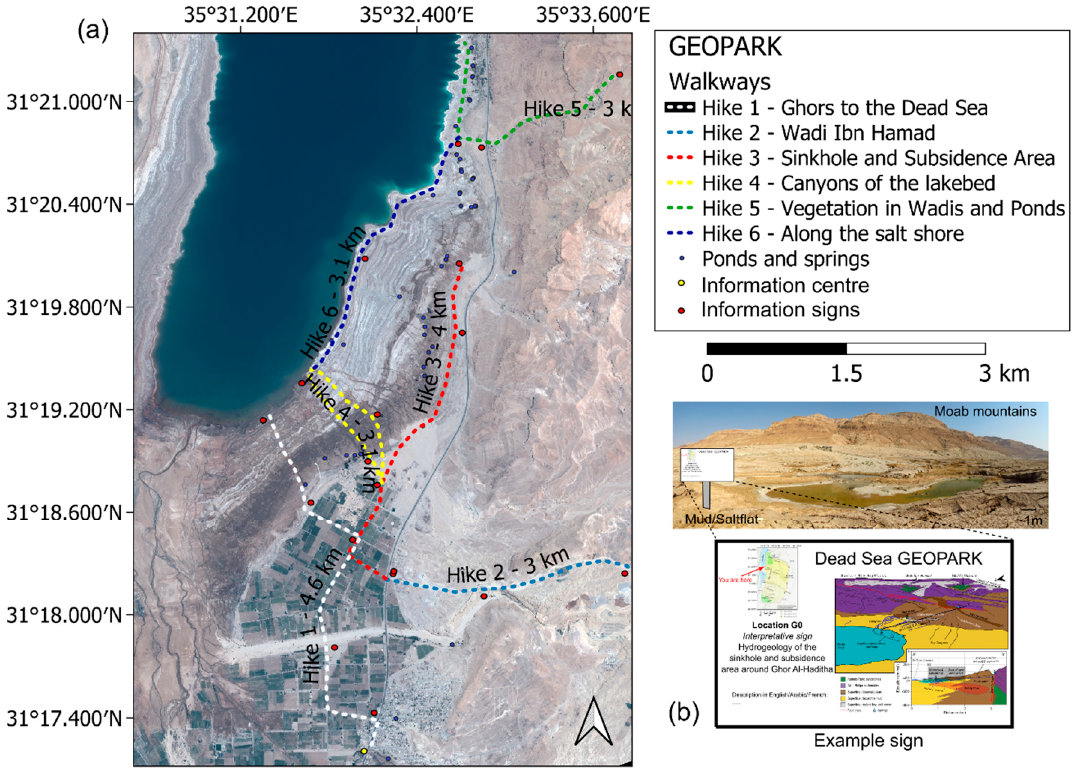
Figure 14. Hiking trail planning for the highlight area of the UGGp. ( a ) Suggested walkways in the sinkhole and subsidence zone around Ghor Al-Haditha. ( b ) is an example of a geological interpretation map for the geopark area, which can be used, e.g., in the geological museum, along the walkways for education purposes. Geological map modified after [26]. Naturally, all signs in the geopark will be translated into English, Arabic and other